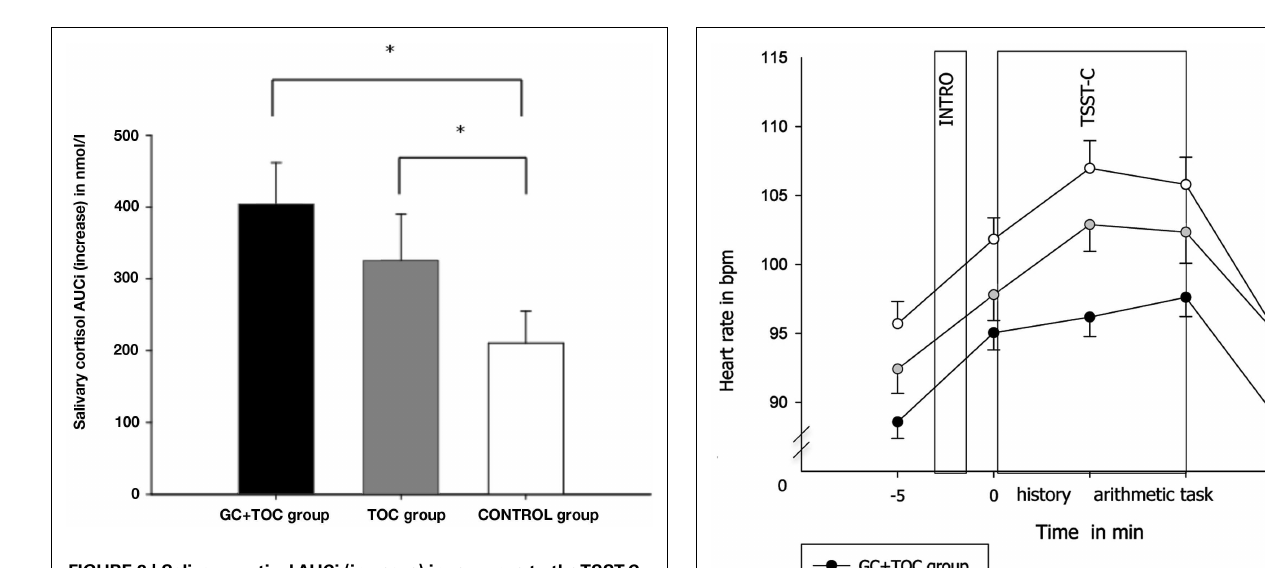
FIGURE 2 | Salivary cortisolAUCi (increase) in response to theTSST-C (MEANS ± SEM) in children with glucocorticoid and tocolytic administration (GC + TOC; n = 43), in children of theTOC group ( n = 35), and in children of the CONTROL group ( n = 37) (* p < 0.05). differences between the groups were obtained for both the total amount of heart rate [AUCg, F (2, 97) = 6.886, p = 0.002, partial η 2 = 0.124], but not for the total amount of heart rate increase [AUCi, F (2, 97) = 0.604, p = 0.549]. The total amount of heart rate was significantly higher in the GC + TOC group as compared totheTOCgroup( posthoc analysis, p = 0.024)aswellascompared to the CONTROL group ( post hoc analysis, p = < 0.001).